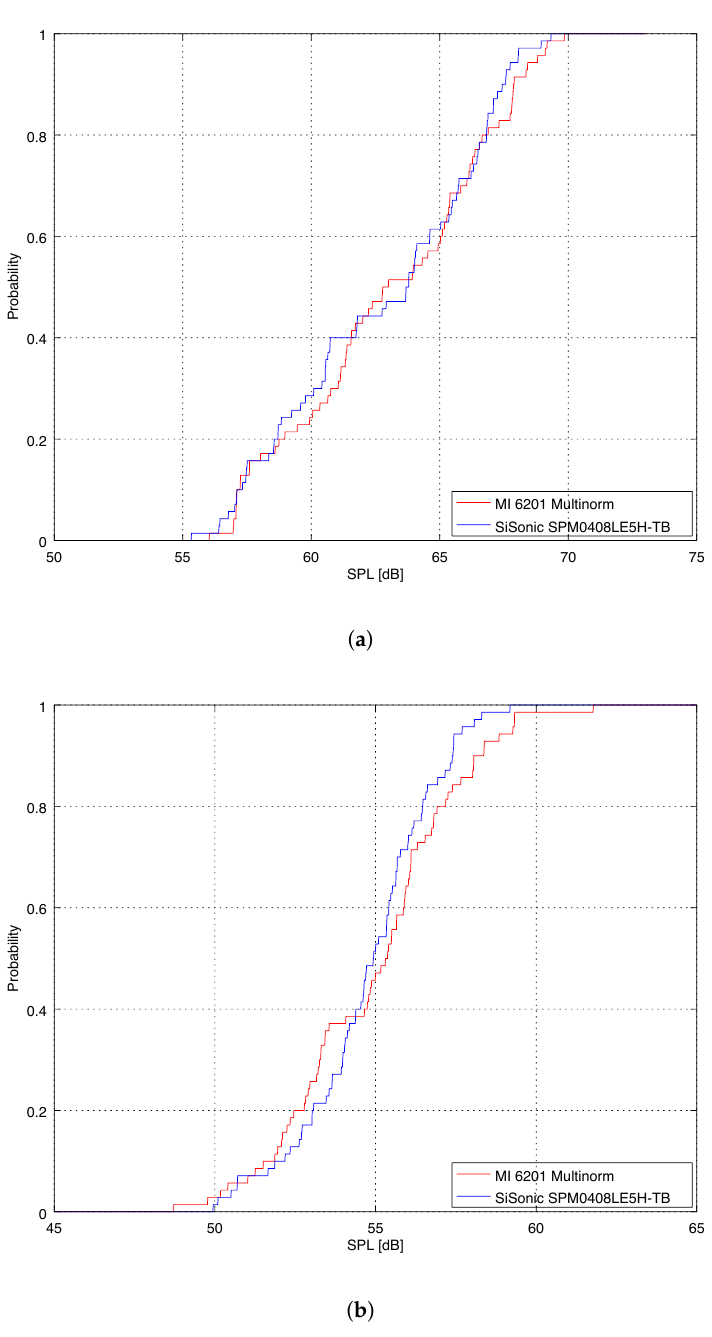
Figure 13. ( a ) Cumulative distribution function of SPL samples in the department hall; ( b ) Cumulative distribution function of SPL samples in the office with six